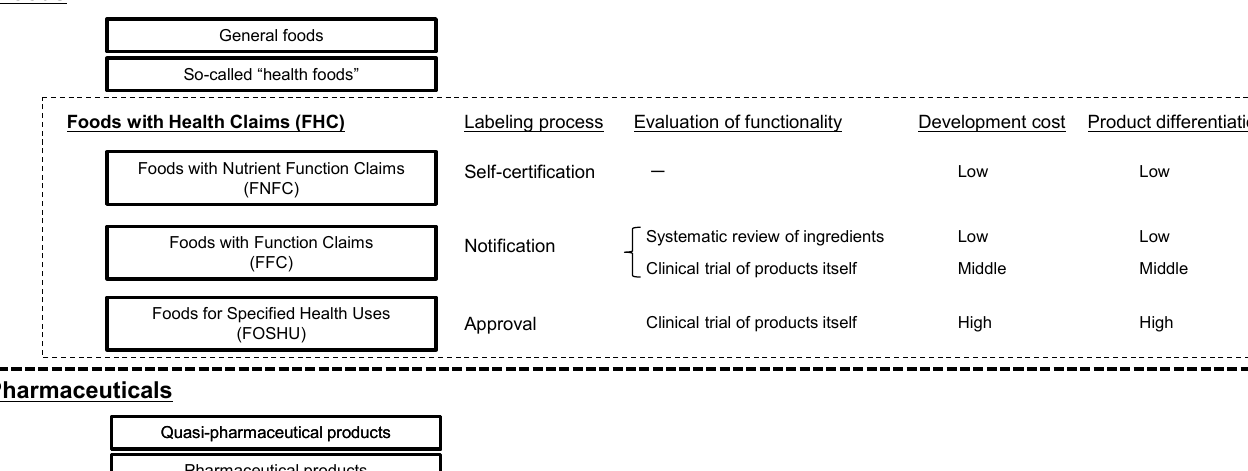
Figure 1. Food with health claims (FHC) system in Japan.